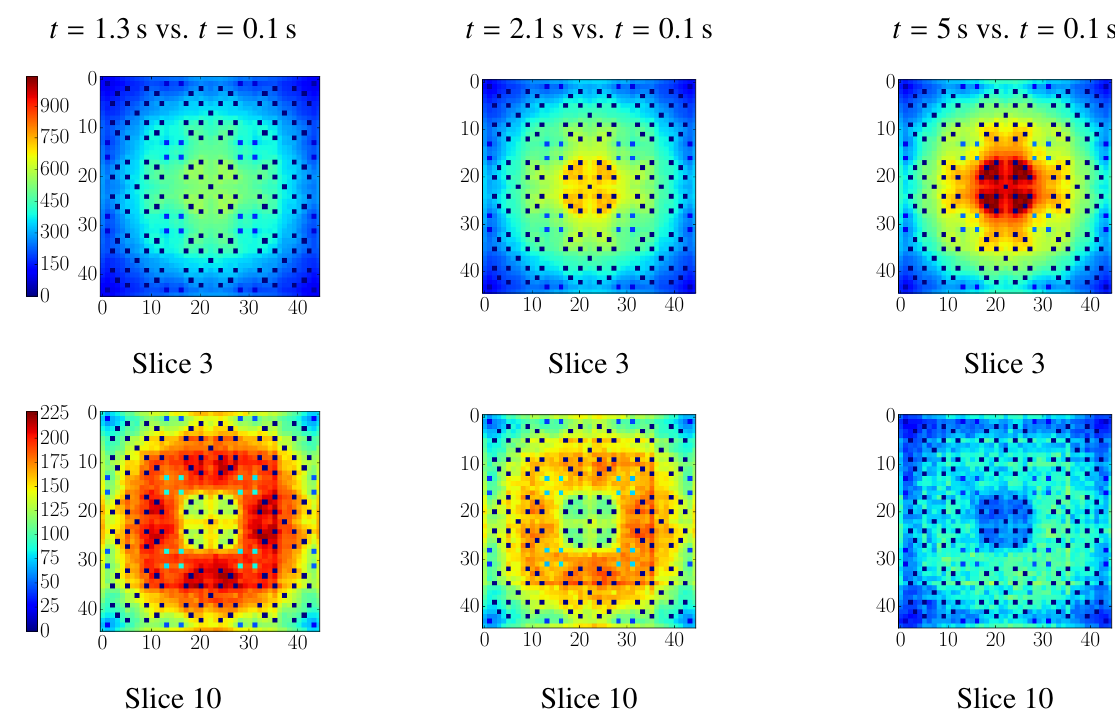
Figure 4: Radial maps of the increase in the fuel temperature (in kelvins), for the simulations in Figs. 2 and 3 (40 cm extraction), at three di ff erent times: t = 1 . 3 s, t = 2 . 1 s and t = 5 s, relative to t = 0 . 1 s. Top: temperature map for slice 3. Bottom: temperature map for slice